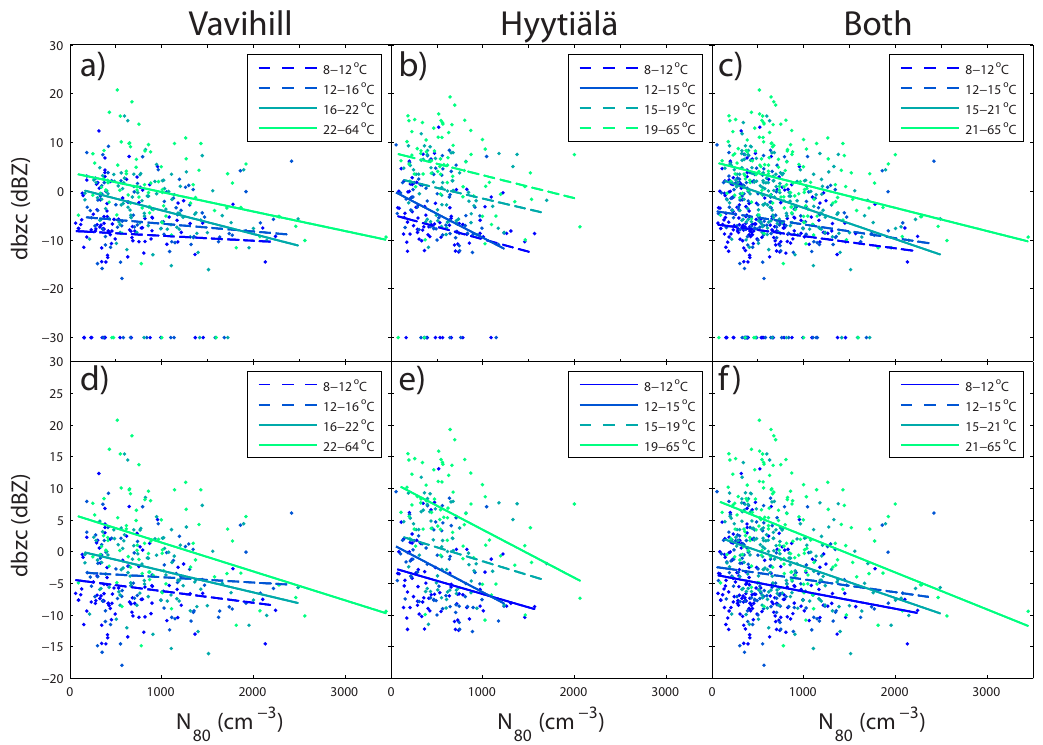
Fig. 8. Radar reflectivity vs. aerosol number concentrations for particles with a diameter greater than 80nm for Vavihill ( a and d ), Hyytiälä ( b and e ) and both datasets combined ( c and f ). Each dataset has been divided into 4 subsets according to dT and a trend line calculated for each dataset. Shown in the legend are the limits of dT for each subset. Lines that are solid have a p value smaller than 0.05 while dashed lines have a p value greater than 0.05. p values below 0.05 mean that the correlation is significant with a 95% confidence interval. Days when there is no precipitation detected by the radars are included in subfigures ( a–c ) and omitted in subfigures (d–f)